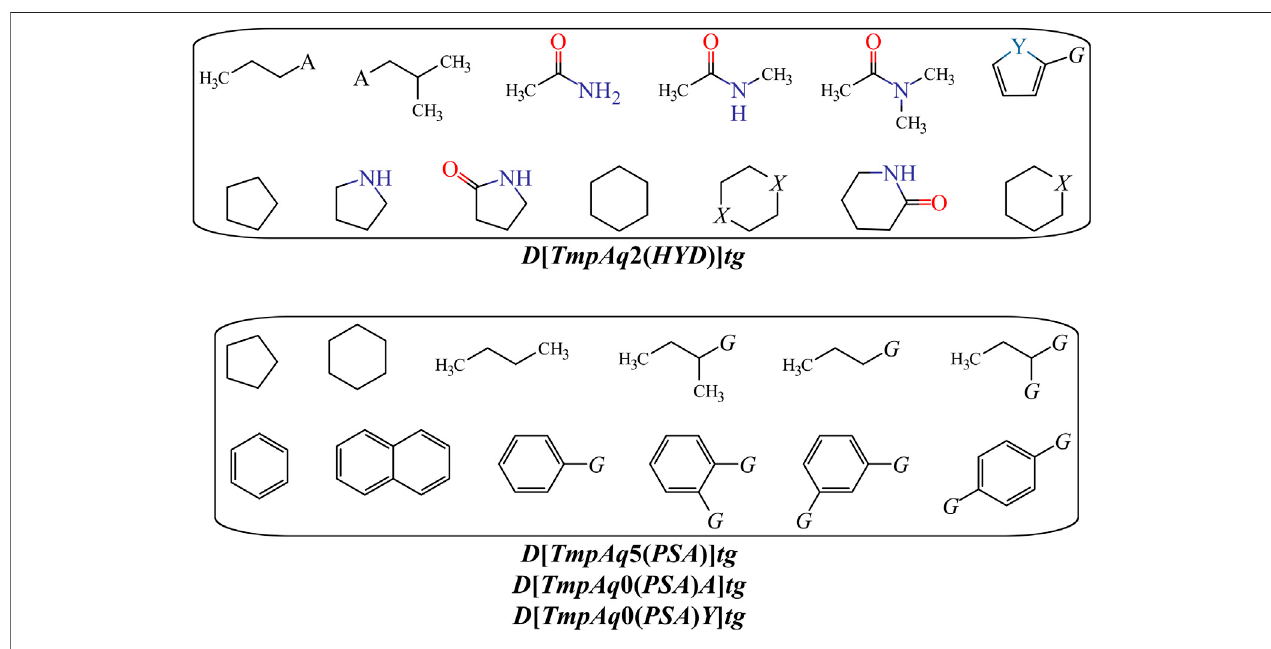
FIGURE 3 | Fragments with positive in fl uence to the increase of the hydrophobic contribution { D [ TmpAq2 ( HYD )] tg } or the decrease of the PSA { D [ TmpAq5 ( PSA )] tg , D [ LmpAq0 ( PSA ) A ] tg , and D [ LmpAq0 ( PSA ) Y ] tg }. Here, A (cid:1) − NH2, − OH, or R (alkyl group); X (cid:1) O or − NH − ; Y (cid:1) S; G (cid:1) Cl, Br, or I.